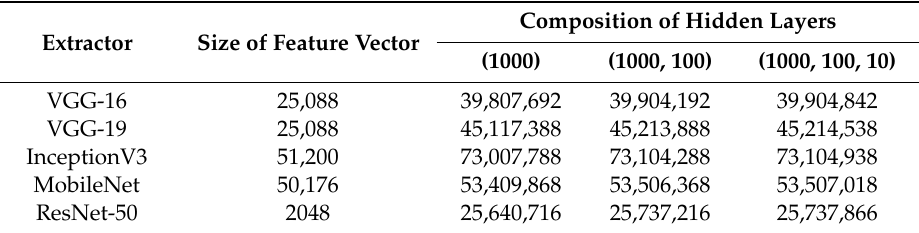
Table 7. The total number of parameters of di ff erent model structures.